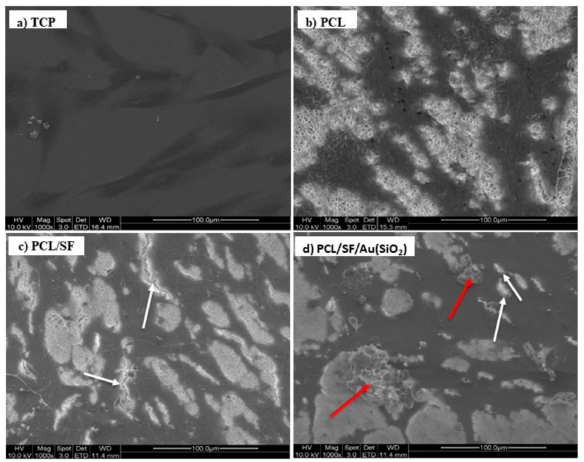
Figure 6. FESEM images showing the cell-biomaterial interactions on ( a ) TCP, ( b ) PCL ( c ) PCL / SF and ( d ) PCL / SF / Au(SiO 2 ) nanofibrous sca ff olds on day 21. Red arrows indicate the minerals secreted by hMSCs, while white arrows refer to the filopodia